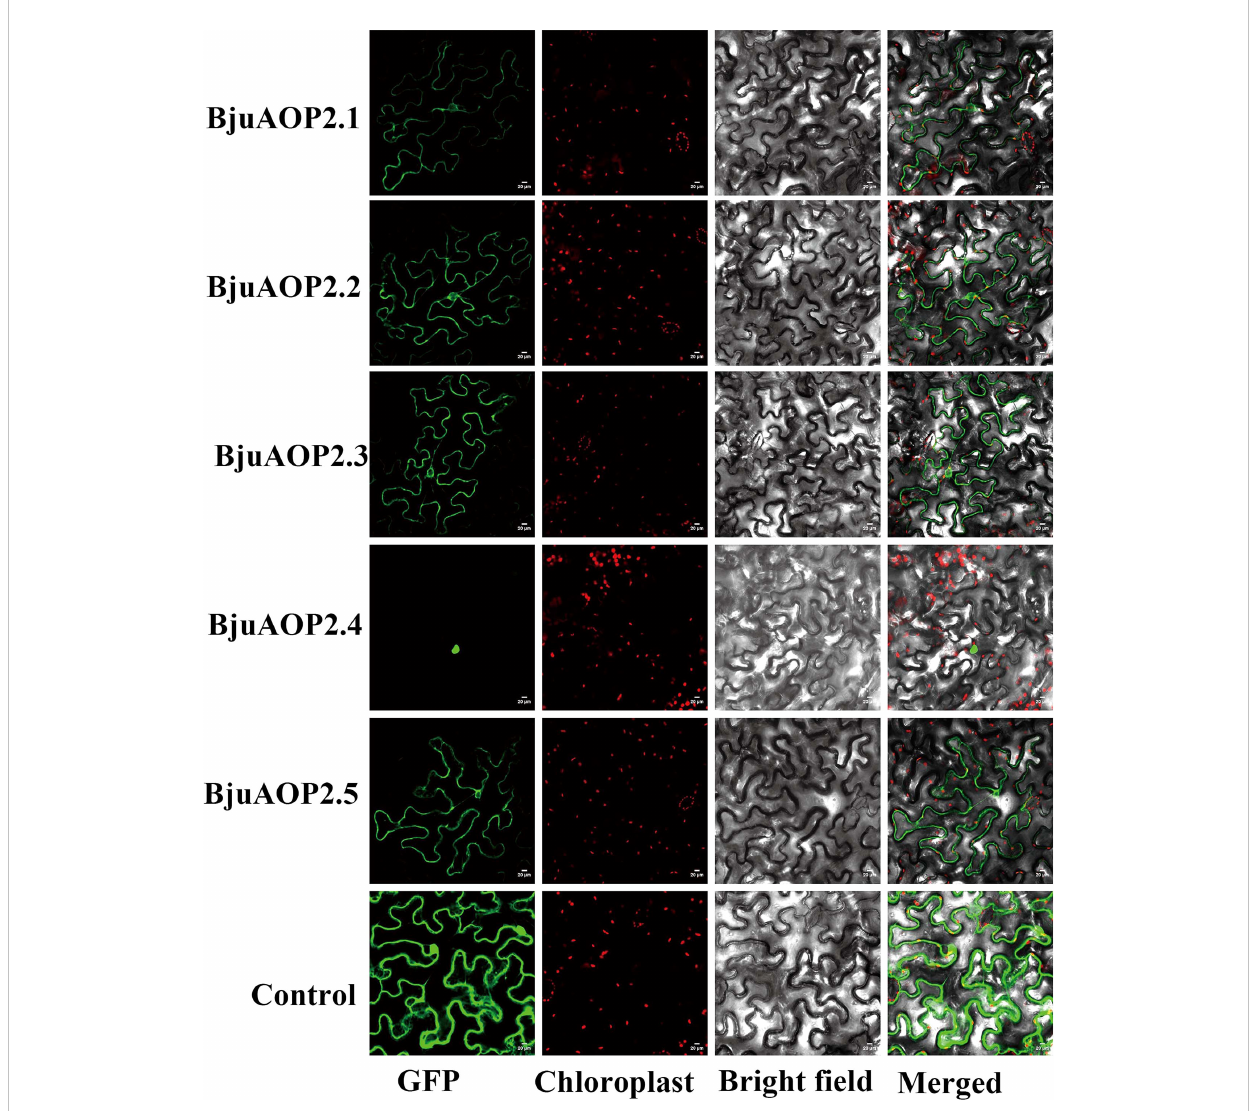
FIGURE 5 Subcellular localization of BjuAOP2 proteins in Nicotiana benthamiana . These genes were fused with the GFP protein driven by the 35S promoter. Green fl uorescence and chloroplast auto fl uorescence (red) images were captured in a dark fi eld; however, a bright fi eld was used to get images of cell appearance. Bar=20 m